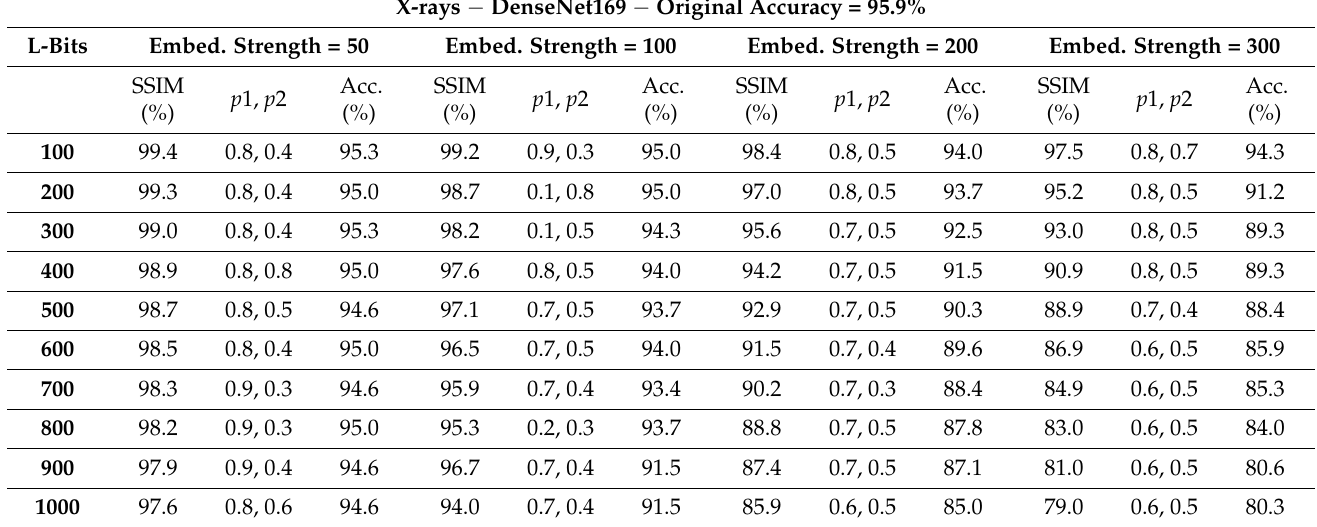
Table 3. KMsWA 2 attack on DenseNet169 in X-rays. X-rays − DenseNet169 − Original Accuracy = 95.9%